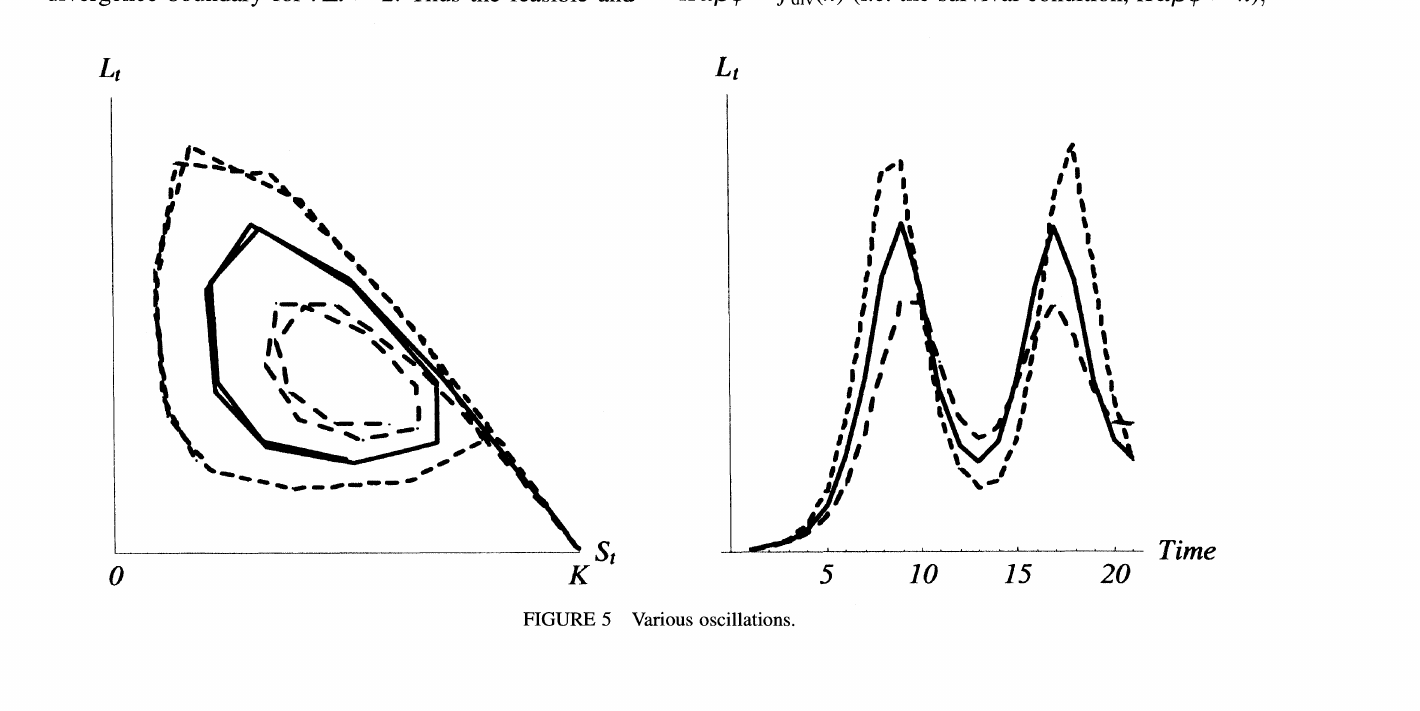
FIGURE 5 Various